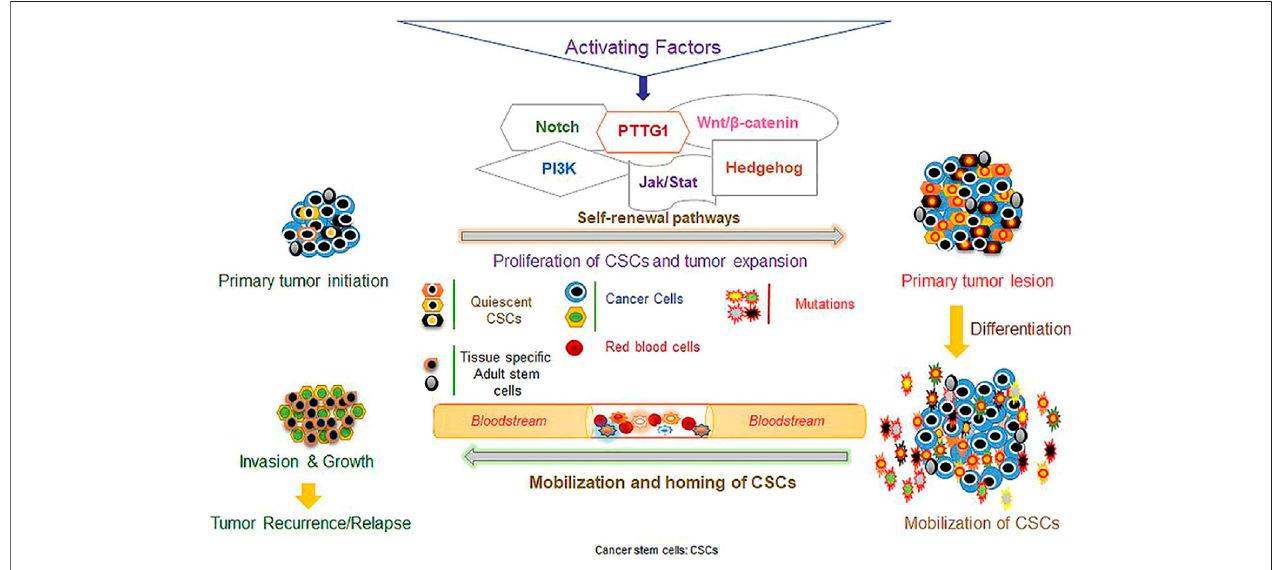
FIGURE 1 | Different factors and signaling pathways mediating stem cell self-renewal, differentiation, and metastasis. (The fi gure was reprinted from Zuber et al. ’ s (2020) study.)